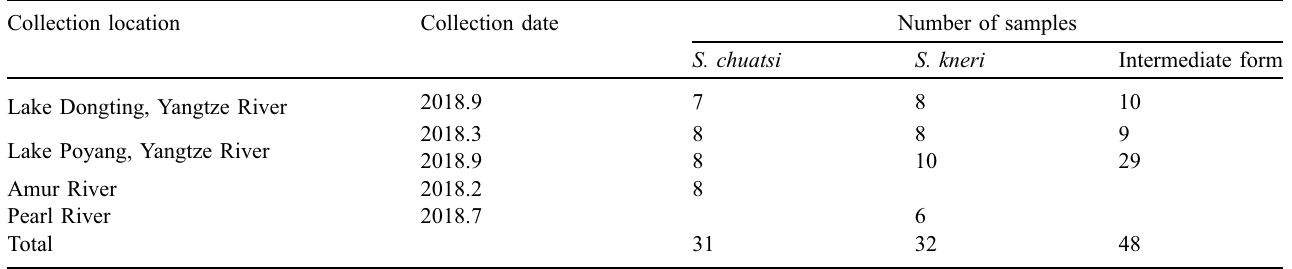
Table 1. Sampling information of S. chuatsi , S. kneri and the intermediate